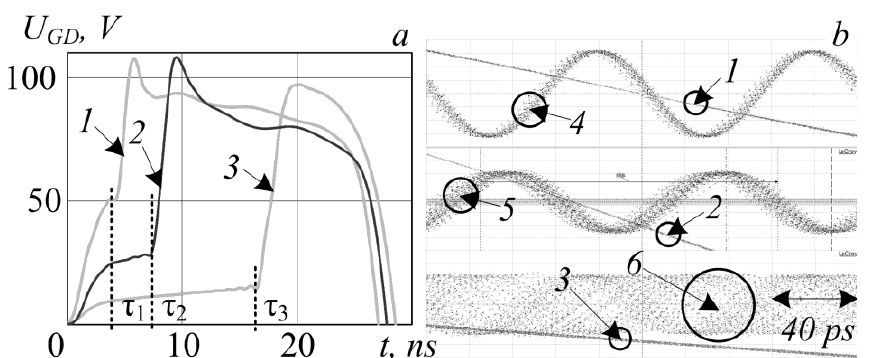
Figure 5 – (a) Oscillograms of the modulating pulse and (b) set of 2500 superimposed oscillograms of the modulating pulse and the microwave signal at different voltage rise